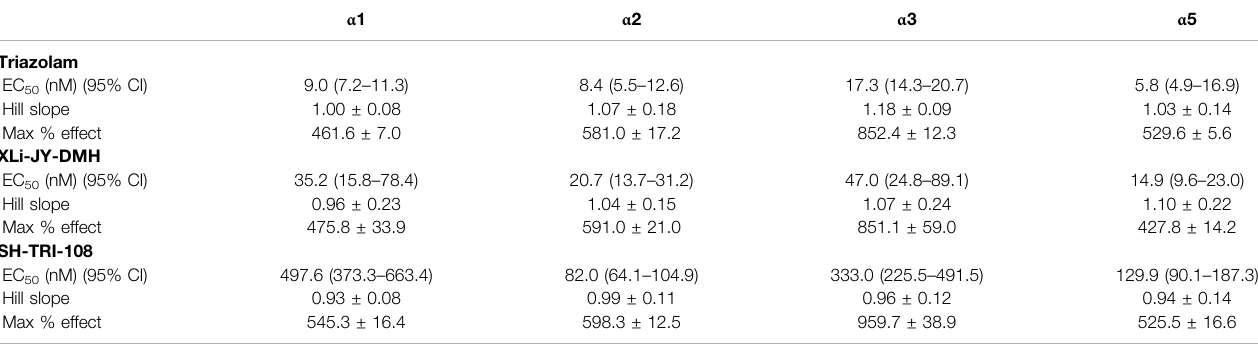
TABLE 3 | Intrinsic ef fi cacy and potency of benzodiazepine receptor ligands at recombinant GABA A receptors containing α X β 3 γ 2 subunits, measured by patch-clamp